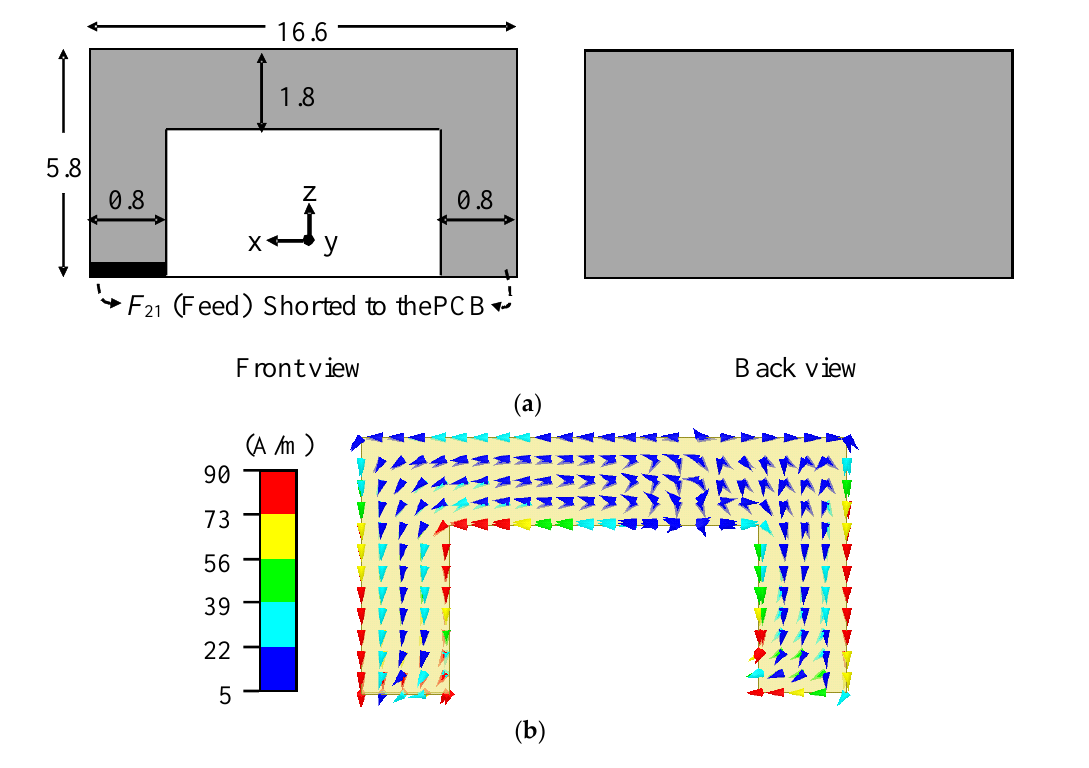
Figure 4. ( a ) The geometry and ( b ) surface current distributions for the 2.45 GHz loop antenna (all measurements are in mm). Table 2. Comparison of antenna dimensions for WLAN applications.